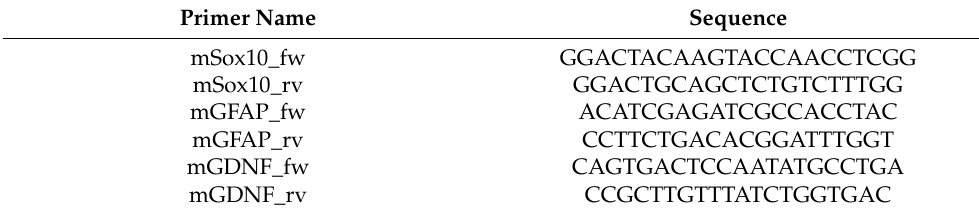
Table 1. Primers used for RT-PCR of Sox10, GFAP and